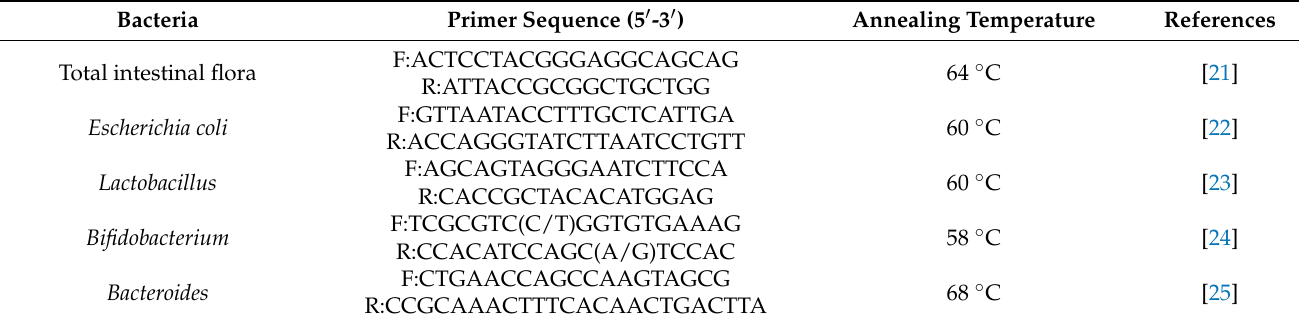
Table 1. Primer sequences of five